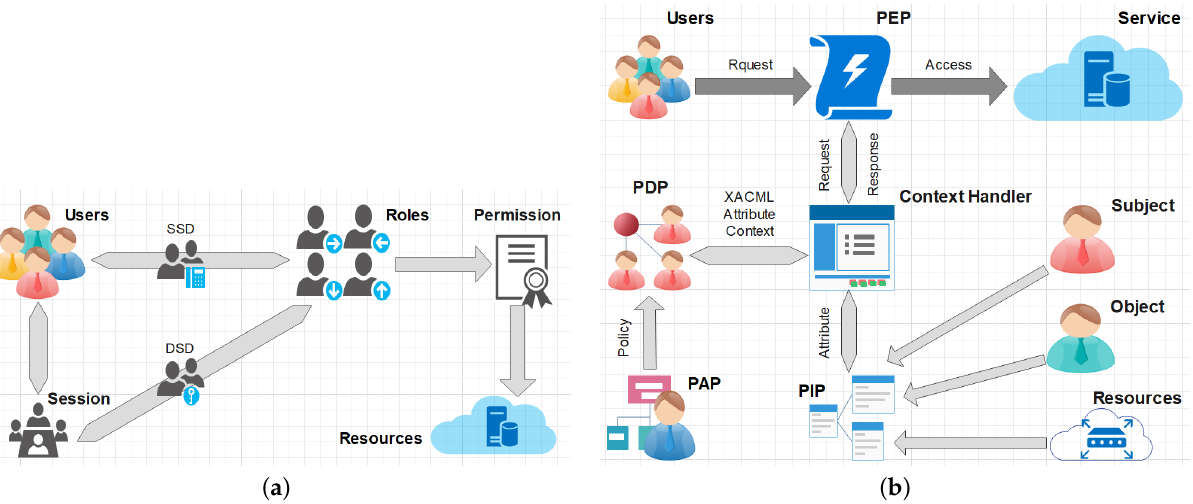
Figure 2. The architecture based on RBAC and ABAC. ( a ) RBAC based Architecture. ( b ) ABAC based